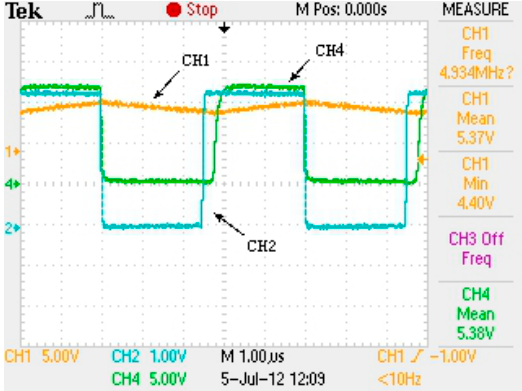
Figure 4. Four-phase interleaving PWM signals.